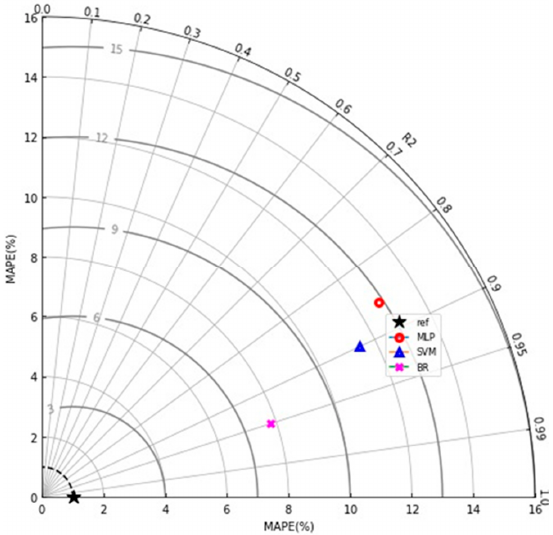
Figure 17. Statistical indication of the model’s performance by Taylor diagram. Figure 16. Statistical indication of the model’s performance by Taylor diagram.